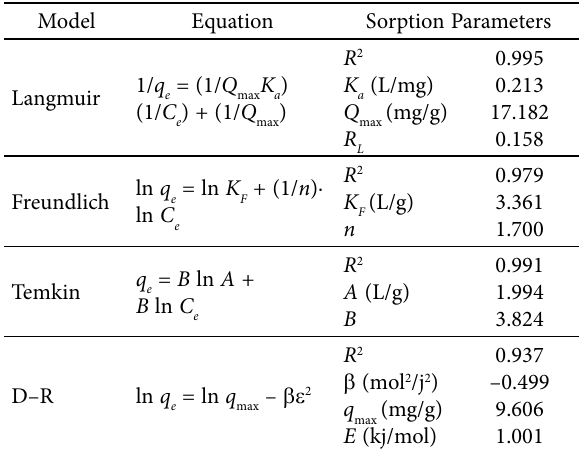
Table 1. Sorption parameters and correlation coefficients